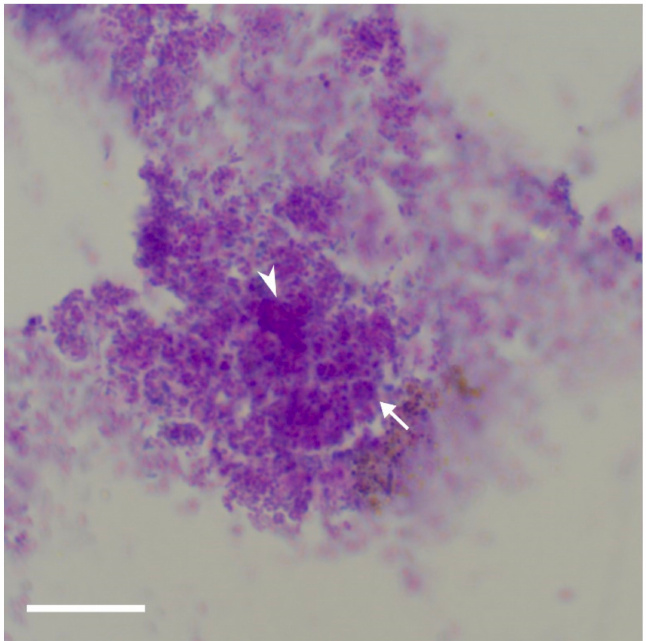
Figure 7. Periodic-acid Schiff stain showing bacteria within stained aggregate. As this is three- dimensional, we can see in-focus bacteria, indicated by white arrows, and out-of-focus bacteria, indicated by white arrowheads, Courtesy Henrietta Parnell-Turner, Animal Dermatology Clinic, 5610 Kearney Mesa Road, San Diego, CA 92111, USA [24]. Bar = 15 µ